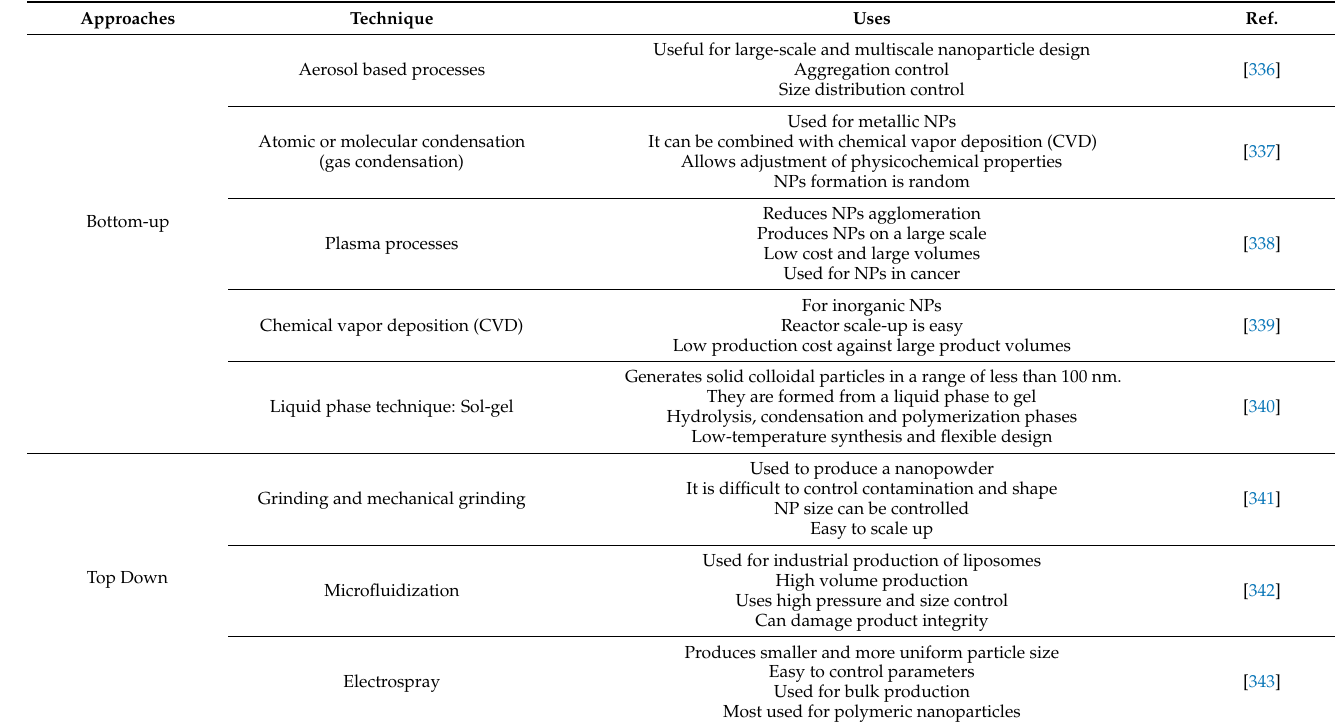
Table 3. Industrial NP production